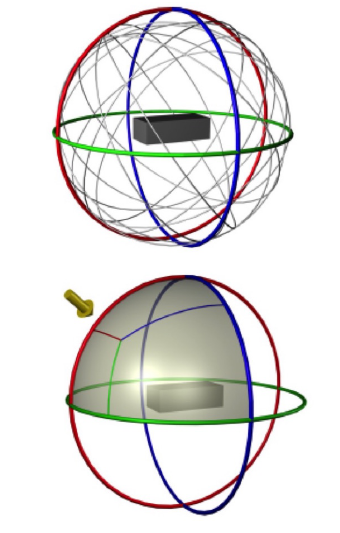
Figure 4. The full aerodynamic load map for a given shape requires finely-resolved azimuthal variations about any arbitrary axis of rotation. From [115]. By permission of